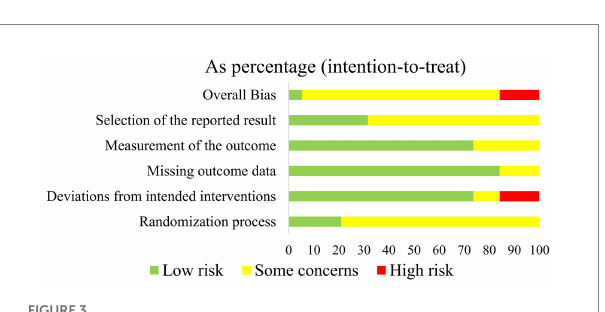
FIGURE 3 Results of risk-of-bias (RoB 2.0) assessment. Proportions of individual study for each